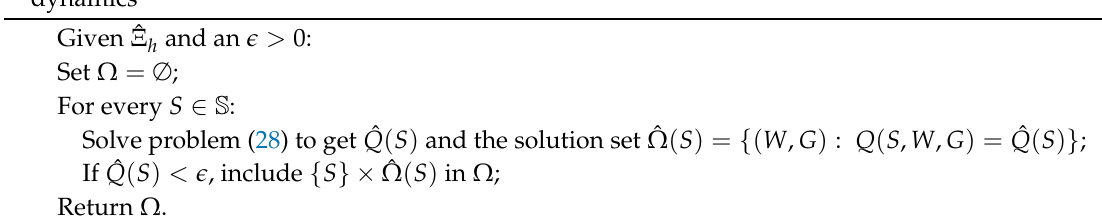
Algorithm 1: Identification of stoichiometry and rate parameters from a model of the moment